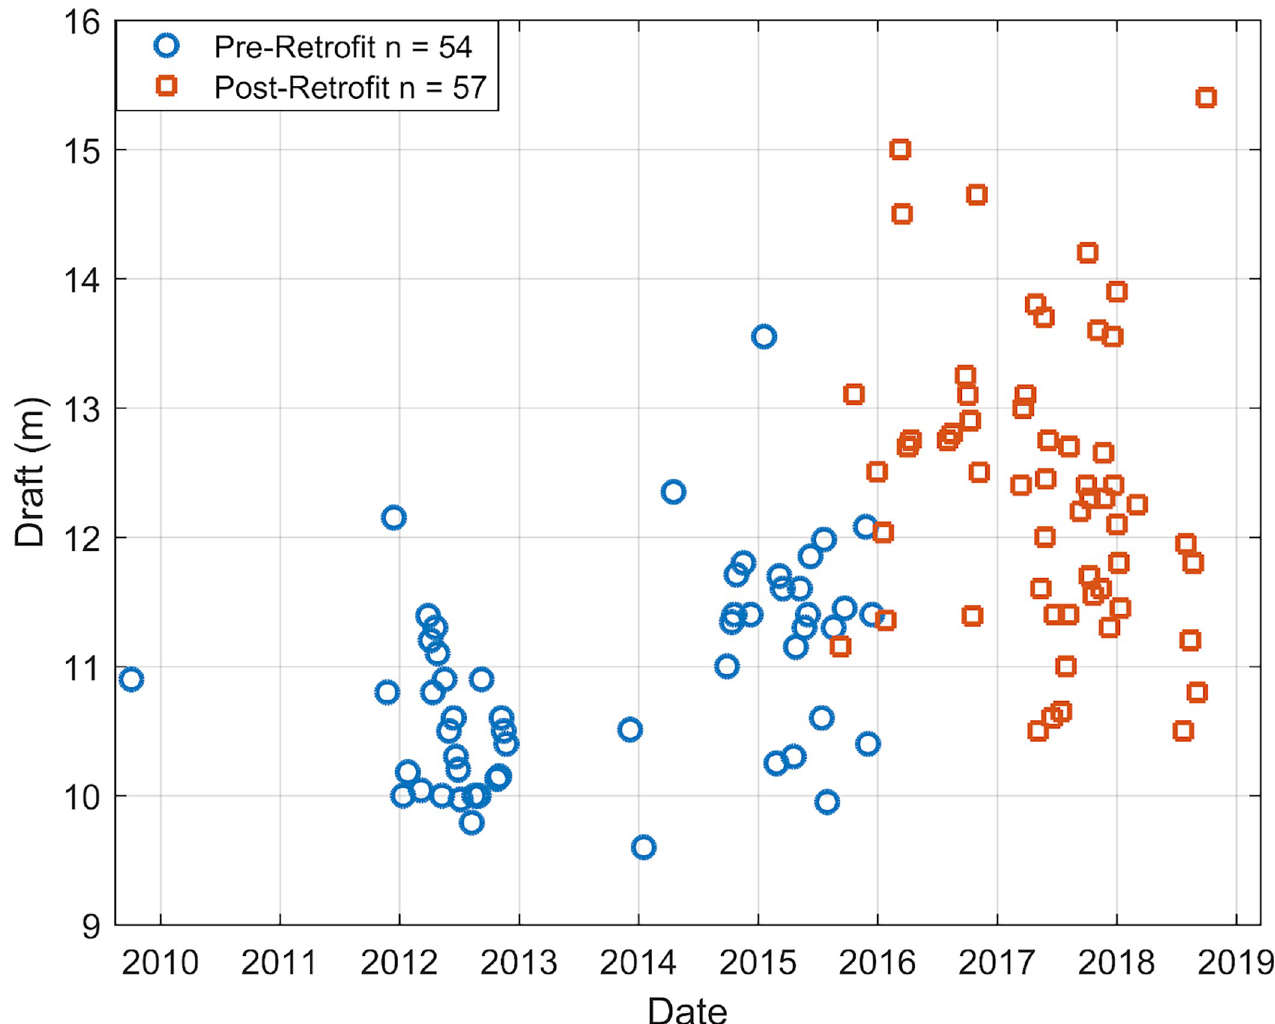
Fig 3. G-Class Maersk vessel draft measurements. G-Class Maersk vessel draft measurements pre-retrofit (blue circles) and post-retrofit (red squares), provided by vessel Chief Engineers. Pre-retrofit draft measurements were shallower on average than post-retrofit draft measurements.